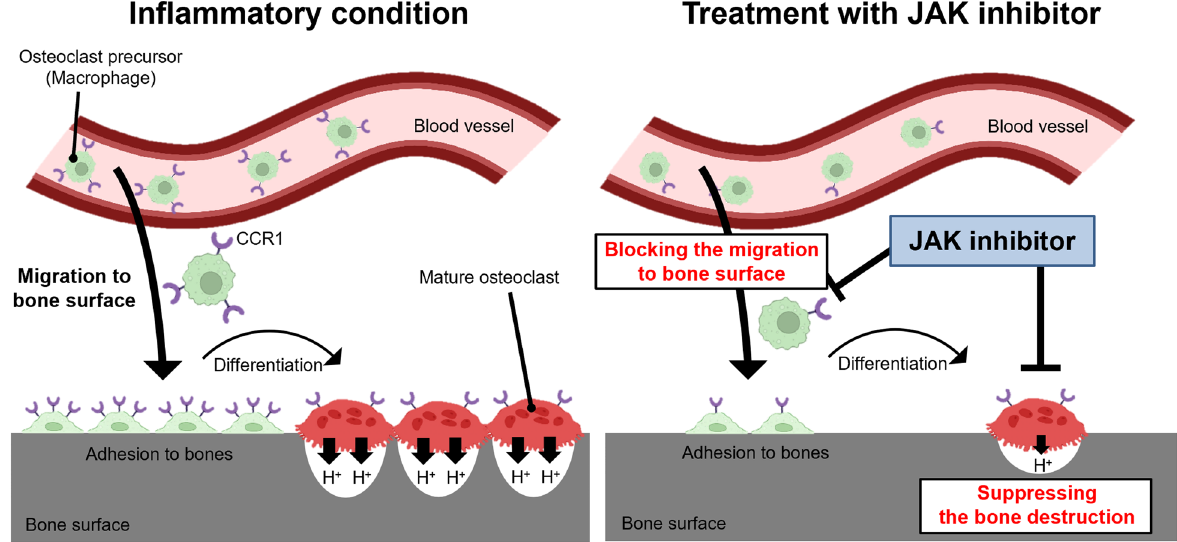
Fig. 4 Scheme of the effects of JAK inhibitor on osteoclasts in vivo. Under inflammatory conditions, many osteoclast precursors migrate to the bone surface at the inflammatory site through CCR1-induced signaling. These cells differentiate into mature osteoclasts and cause abnormal bone destruction (left). JAK inhibitor decreased the expression of Ccr1 on osteoclast precursors and blocked the migration of these cells to the bone surface, resulting in a decrease in the number of mature osteoclasts. In addition, JAK inhibitor suppressed the bone resorptive activity of mature osteoclasts